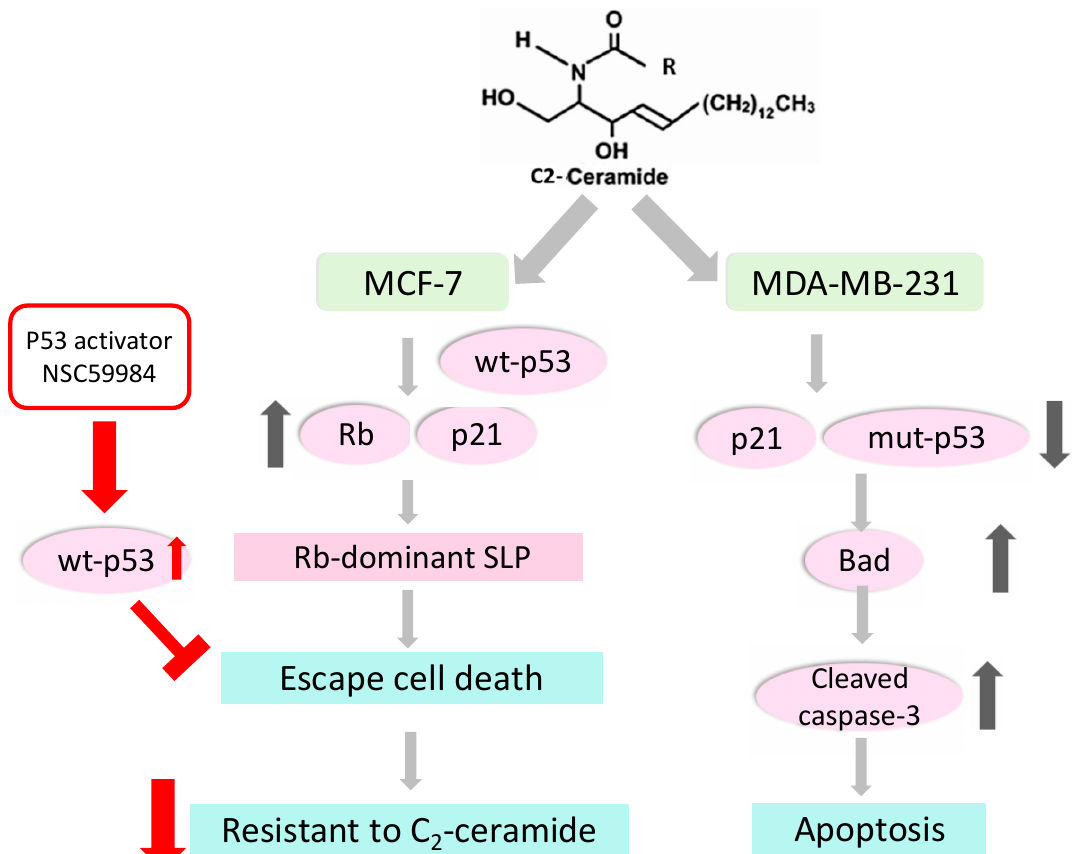
Figure 6. A proposed mechanism whereby breast cancer cells escape C 2 -ceramide-induced apoptosis through modulating senesce-like phenotype. Exogenous C 2 -ceramide inhibits growth arrest and induces apoptosis in breast cancer MDA-MB-231 cells through down-regulating the expression of mutant p 53 while up-regulating pro-apoptosis pathways, including the expression of Bax and Bad and the proteolytic activation of caspase-3. In contrast, C 2 -ceramide treatments that favor the induction of senescence-like phenotype might occur through the activation of Rb rather than the activation of p 53-signaling of senescence. Rb-mediated senescence-like phenotype (SLP) might be reversible and confer more resistance of breast cancer MCF-7 cells to C 2 -ceramide. In contrast, the activation of wild type p 53 using a p 53 activator resensitizes MCF-7 cells to C 2 -ceramide, suggesting the critical role of wild type p 53 in C 2 -ceramide-induced death in breast cancer cells. Therefore, the proposed model suggests that some cancer cells escape apoptosis induction through modulating senescence-like phenotype, whereas the p 53 activation can overcome the chemoresistance and should be a promising strategy for treating cancer cells which favor stress-induced SLP. ( ↑ , increase or upregulation; ↓ , decrease or downregulation; T, attenuation or blockade).